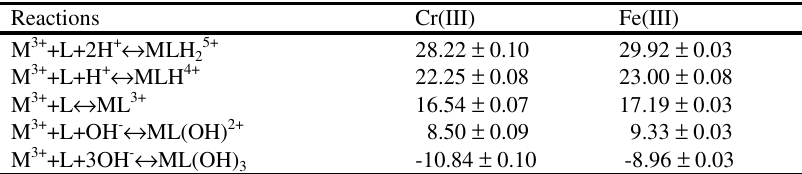
Fig. 3. Species distribution curves for Cr(III)- tmach and Fe(III)- tmach system in aqueous solution at m = 0.1M NaClO 4 and 25 – 1 (cid:176) C. Table 1. The complexation reactions and their overall stability constants (log b ) values at m = 0.1M NaClO 4 and 25 – 1 (cid:176) C